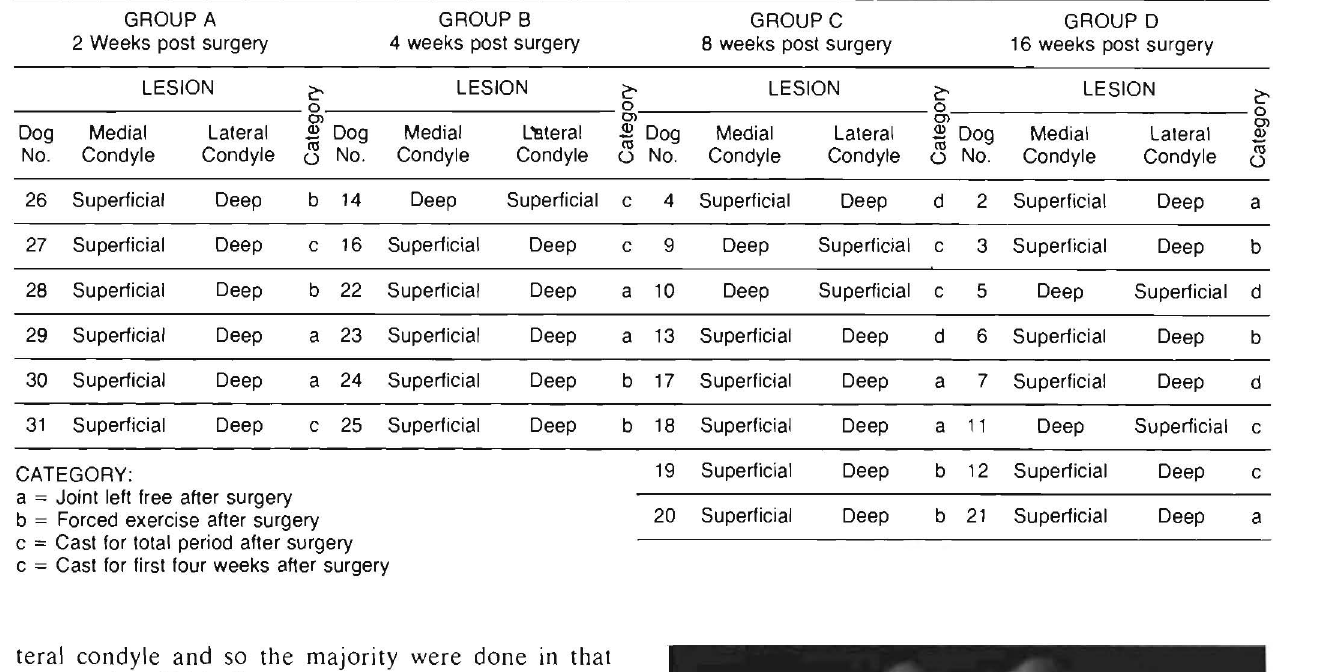
Table 1: CLASSIFICATION OF 28 DOGS INTO FOUR GROUPS THE ANIMALS WERE DESTROYED AND THE JOINT LESIONS EXAMINED HISTOLOGICALLY TWO, FOUR, EIGHT AND SIXTEEN WEEKS AFTER SURGERY GROUP A